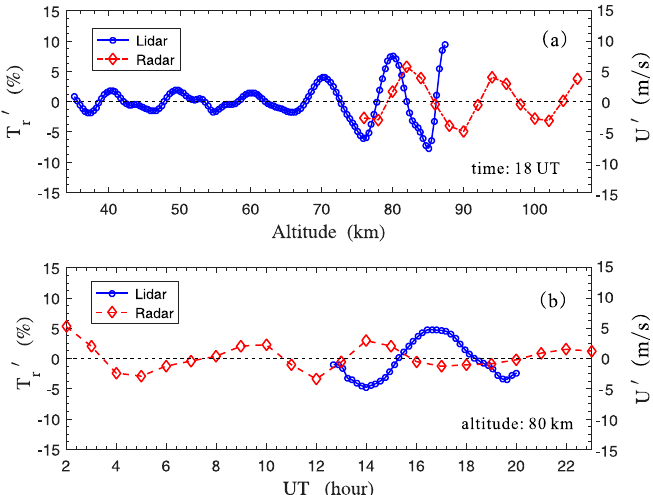
Figure 9. Phase relations between the perturbations of temperature and horizontal wind. ( a ) Perturbation profiles of temperature (circle) and the k -ward horizontal wind (diamond) measured by lidar and meteor radar at 18 UT, respectively. ( b ) Time-varying perturbations of temperature (circle) and the k -ward horizontal wind (diamond) at an altitude of 80 km.